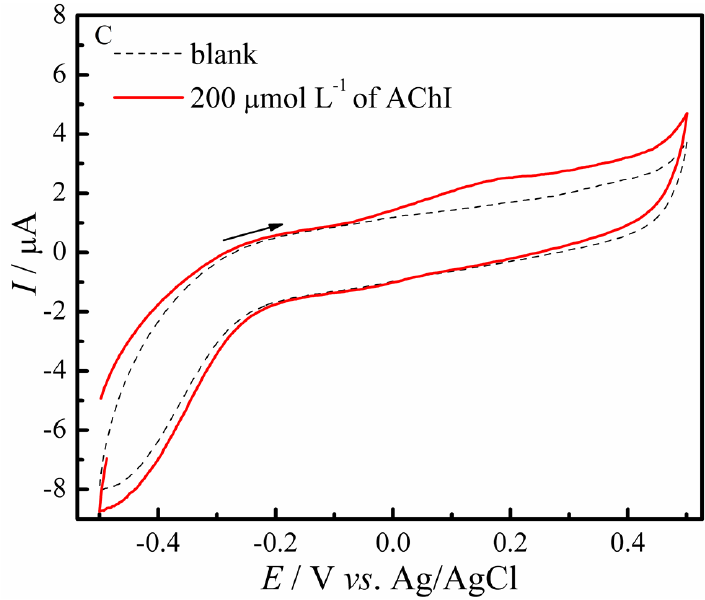
Figure 4. DPV response in the absence (dashed line) and presence (solid line) of 50.0 µmol L − 1 of AChI using the GC/RC/AChE biosensor in 0.2 mol L − 1 PBS solution (pH 7.5).